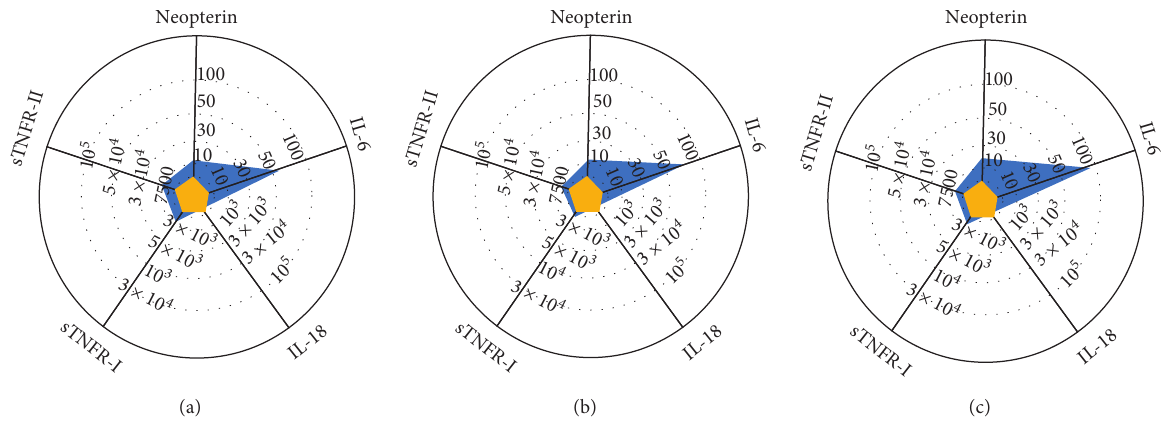
Figure 4: Serum cytokine profiles. (a) At admission. (b) Before intravenous immunoglobulin treatment. (c) Typical KD patients ( N � 64). Overlaid inner yellow pentagons in the chart of KD patients show the mean values of healthy controls. IL, Interleukin; KD, Kawasaki disease; sTNFR, soluble tumor necrosis factor